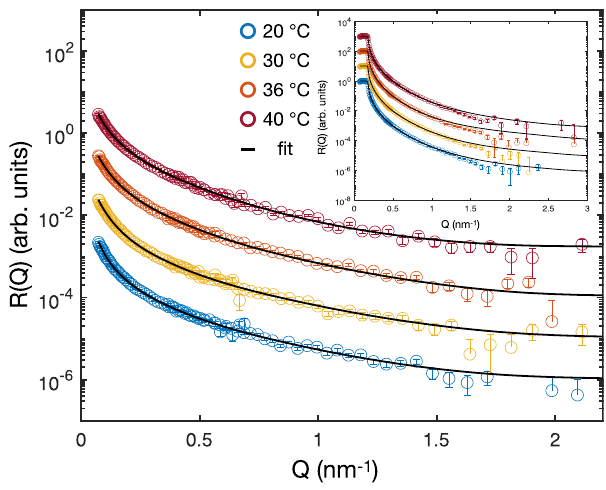
Fig. 4 Re fl ectivity curves of ULC D3 microgels at different temperatures. Re fl ectivity, R(Q), versus momentum transfer, Q , at the air-ACMW interface. The fi ts are shown by continuous lines. Inset: Re fl ectivity curves at air-D 2 O interfaces. The curves are shifted in y-direction for clarity. The unshifted curves are shown in Supplementary Fig. 6c. The error bars represent the statistical errors on